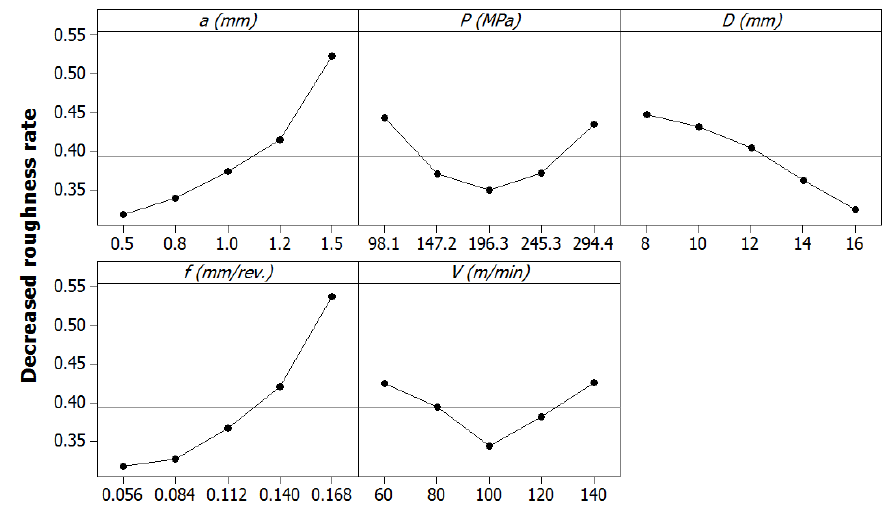
Figure 7. The main effects of machining parameters on the decreased roughness rate.